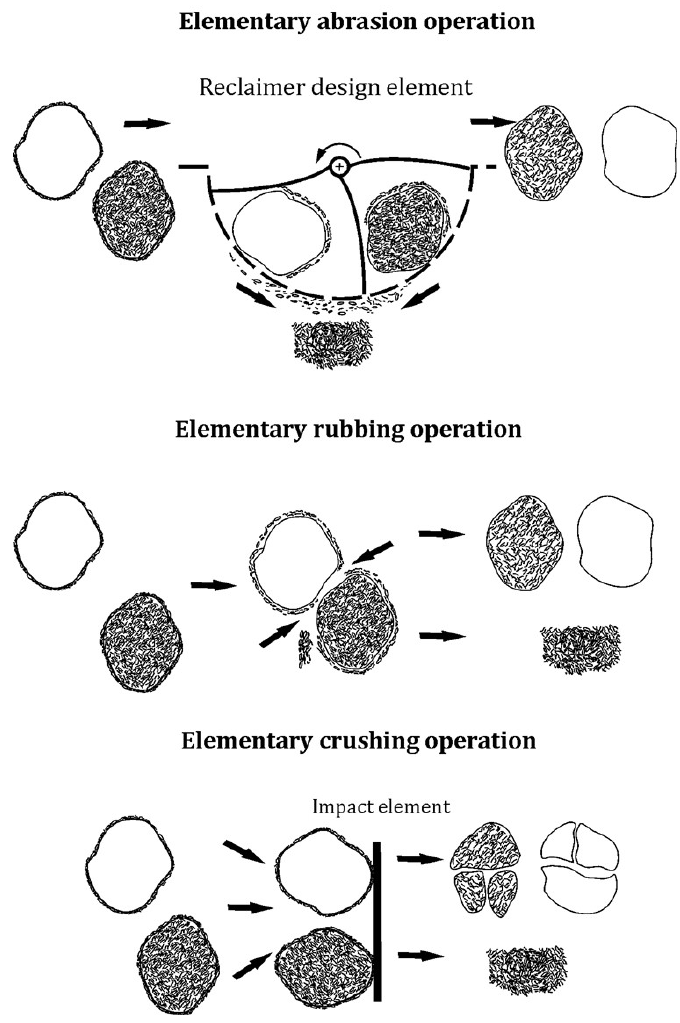
Figure 6. Elementary operations of reclamation process.